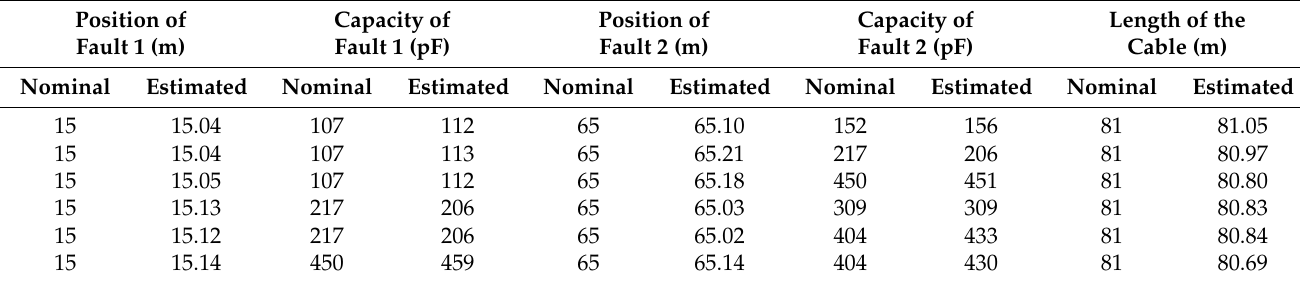
Table 5. Estimation results for real cables with two capacitive faults.